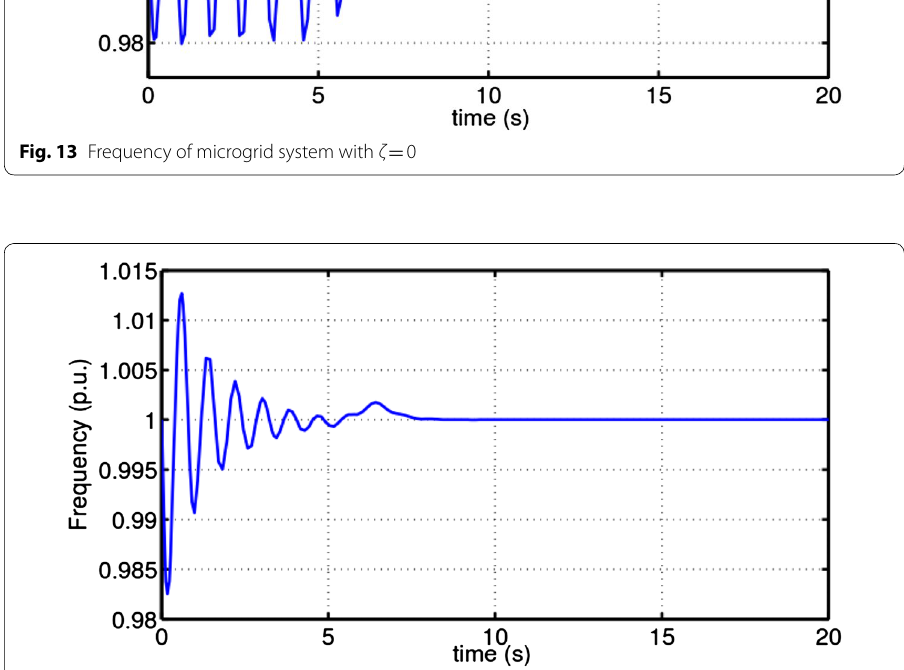
Fig. 14 Frequency of microgrid system with ζ